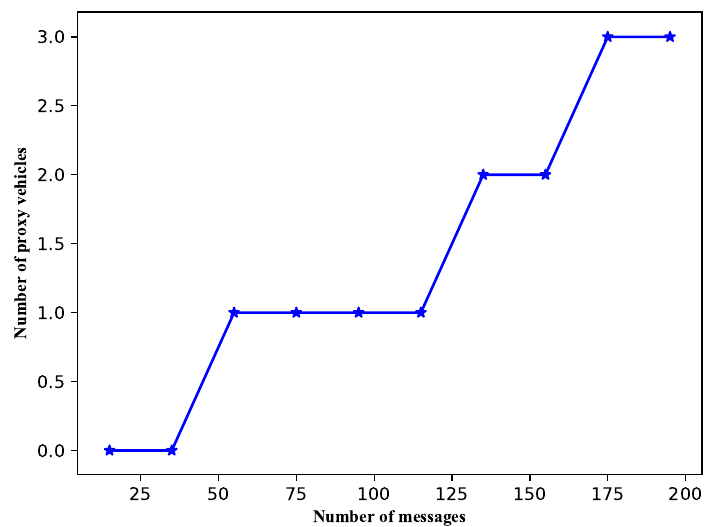
Figure 5. Relationship between the number of messages and the number of proxy